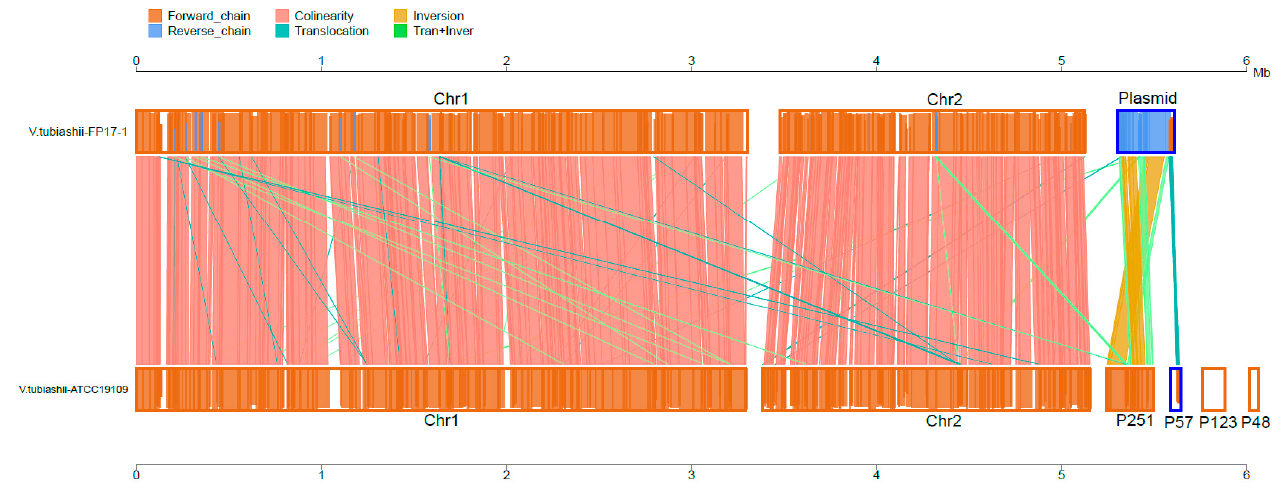
Figure 4. Collinear pairwise comparison of the V. tubiashii FP17 and ATCC19109 strain.